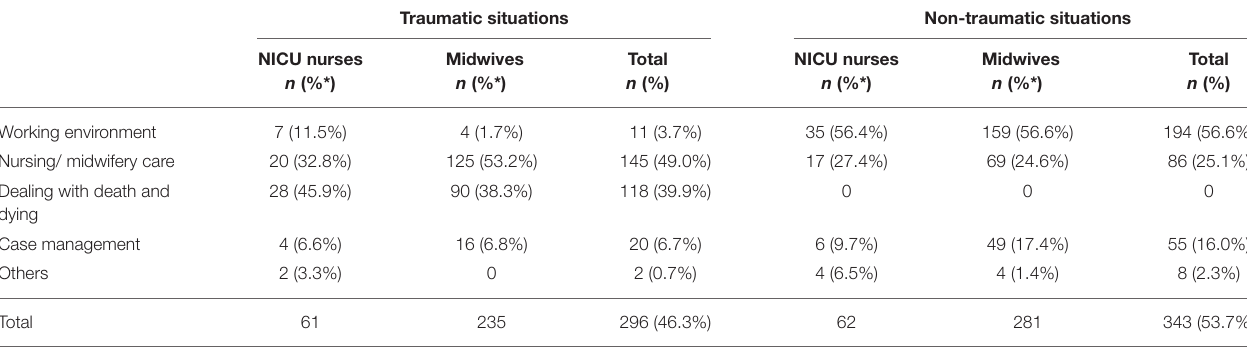
TABLE 4 | Categorization of work-related stressful